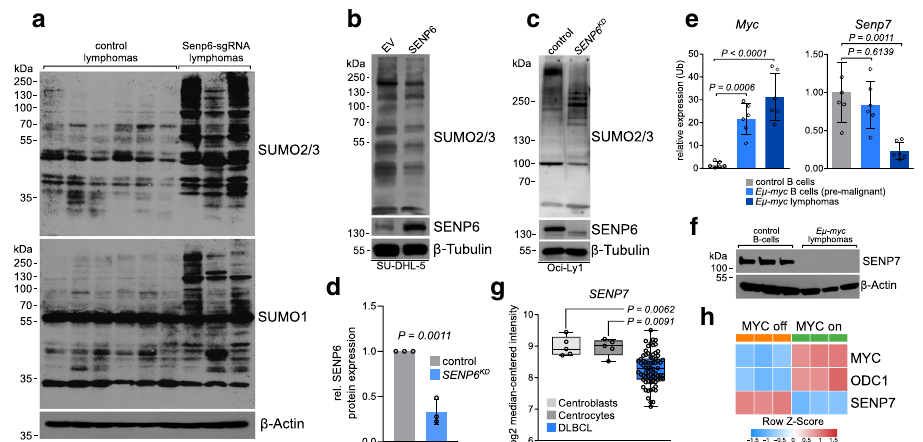
Fig. 4 Loss of SENP6 promotes unrestricted SUMOylation in B-cell lymphoma. a Immunoblot analysis of overall SUMOylation using SUMO1 and SUMO2/3 antibodies. E µ -myc control lymphomas ( n = 6) are compared to Senp6-sgRNA lymphomas ( n = 3) derived from in vivo validation experiments (Fig. 2g, left panel). b Immunoblot analysis of human SU-DHL-5 cells after reconstitution of SENP6 is described in Fig. 3b to investigate the overall status of SUMO2/3-conjugated proteins. EV empty vector control. c Immunoblot analysis of human OCI-Ly1 DLBCL cells after CRISPR/Cas9-mediated depletion of SENP6 to investigate the overall status of SUMO2/3-conjugated proteins. SUMO chains induced by SENP6 depletion are indicated. d Quanti fi cation of the SENP6 western blots in OCI-Ly1 control and SENP6 KD cells. Protein expression of SENP6 in control cells was arbitrarily set to 1. Each dot represents a biological replicate (Data are presented as mean ± SD from n = 3 independent experiments). P -value determined by unpaired t -test (two-tailed). e Senp7 and Myc expression in CD19 + B-cells derived from wild type mice ( n = 6), CD19 + B-cells from premalignant E µ -myc mice ( n = 6) and E µ -myc lymphomas ( n = 6). Senp7 and Myc expression was normalized to Ubiquitin . Data are presented as mean ± SD. P -value determined by one-way ANOVA; Tukey ’ s post hoc test. f Immunoblot analysis of the indicated proteins comparing splenic CD19 + control B-cells ( n = 3) and E µ -myc lymphomas ( n = 3). g SENP7 expression in control B-cell (centroblasts, n = 5; centrocytes, n = 5) and in primary DLBCL samples ( n = 73) in the GSE12195 dataset. The centerline of the box plot is the median. The box extends from the 25th to 75th percentiles. Whisker length is from minimum to maximum. P -value was determined by one- way ANOVA; Tukey ’ s post hoc test. h MYC, ODC1 , and SENP7 expression after the repression of MYC for 24 h in the human P493-6 cell line carrying a tet- repressible MYC transgene in the GSE32219